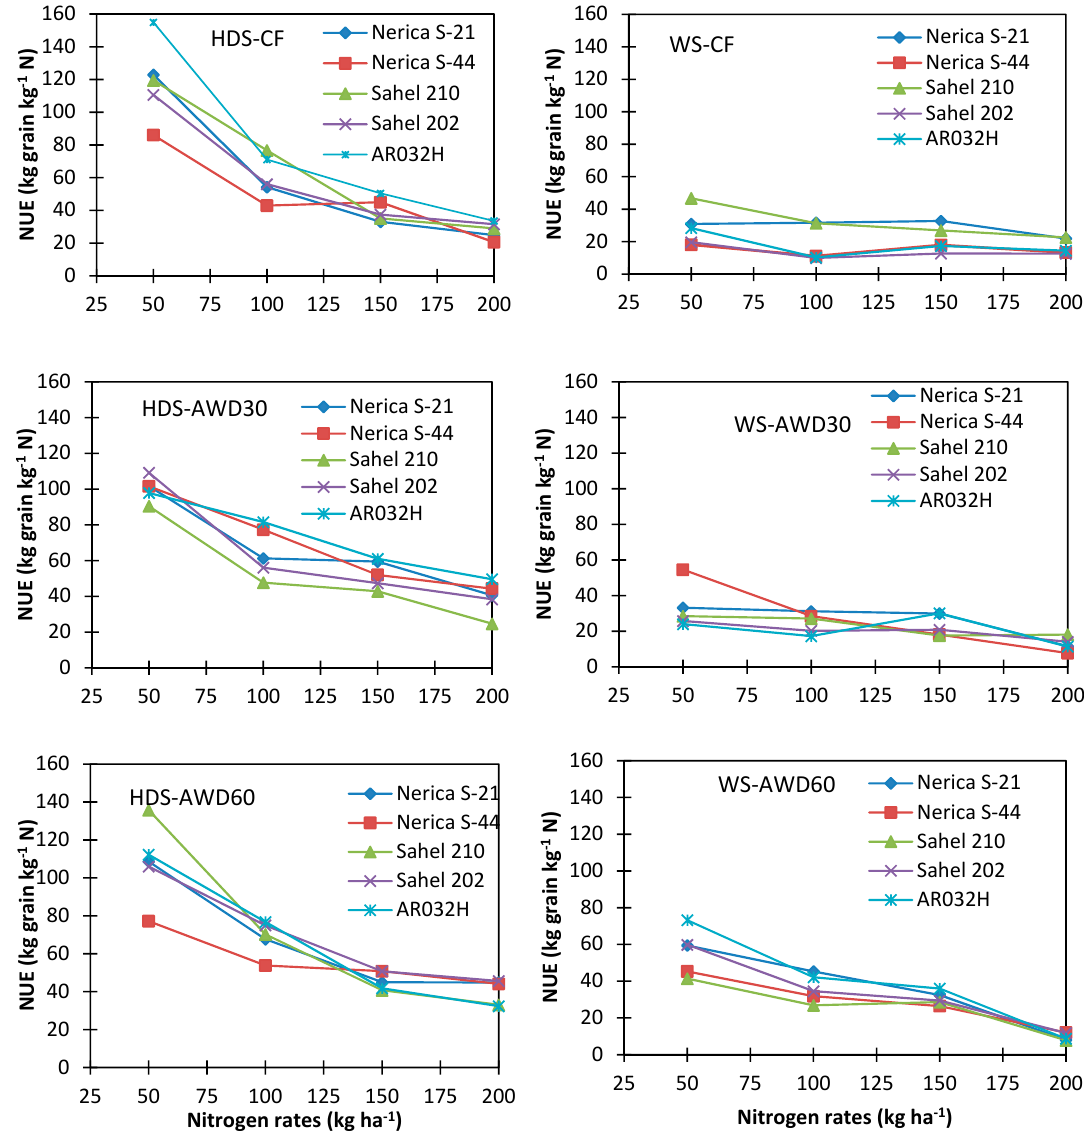
Figure 6. Variation in nitrogen use efficiency (NUE) of five rice genotypes as function of applied nitrogen fertilizer rates.